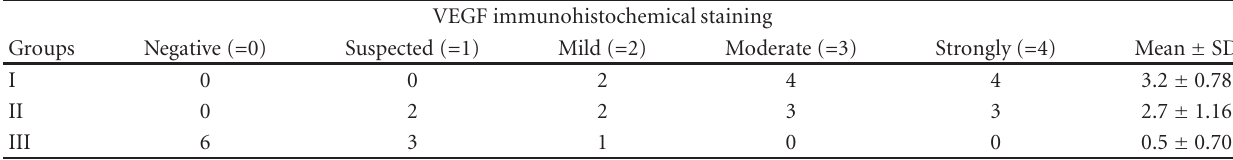
Table 5: The severity of immunohistochemical staining with VEGF